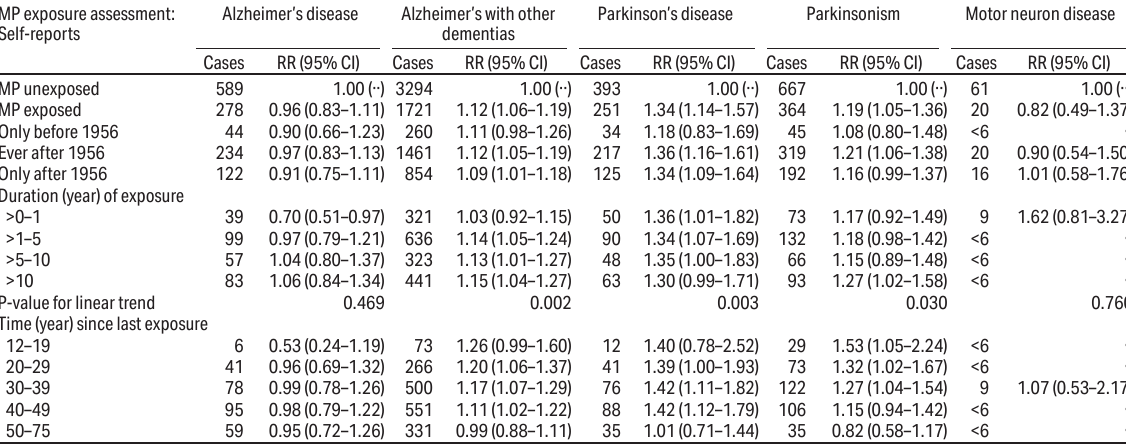
Table 3. Incidence rate ratios (RR) of neurodegenerative disease (1992–2018) by self-reported McIntyre Powder (MP) exposure (periods and duration of exposure and time since last exposure) among male miners in the study cohort. [CI=confidence interval.] a